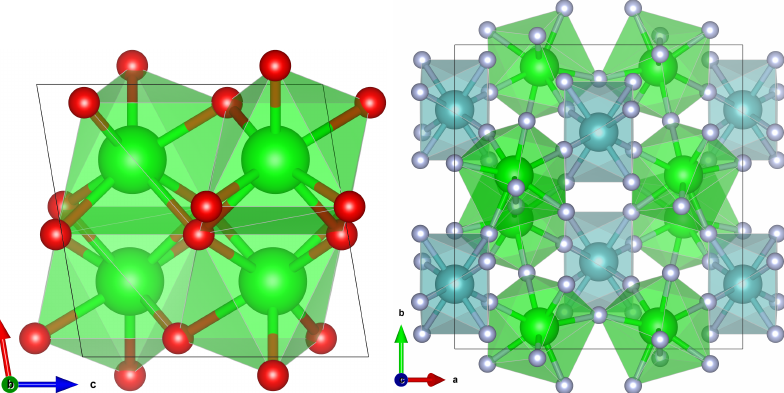
Figure 1. Visualized relaxed structures of ZrO 2 ( left ) and ZrF 4 ( right ). Structures of HfO 2 and HfF 4 closely resemble the depicted ones in geometry, but with slightly shorter bonds (see Tables S5 and S6). Atoms are colored according to: Zr in green/teal, O in red, F in gray. The fluoride structure has two different metal atoms as basis, shown in teal (center A) and green (center B), further explained in Figure 3 left. Unit cell parameters are given in Table 1.